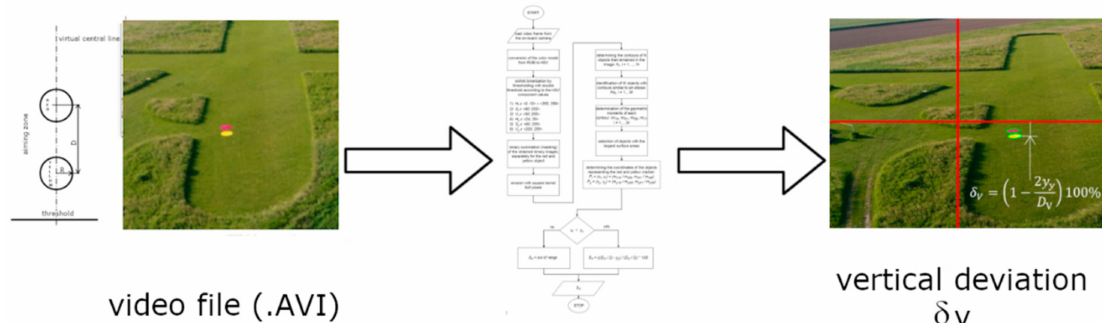
Figure 14. The approach adopted to test the kernel functions of the Vision